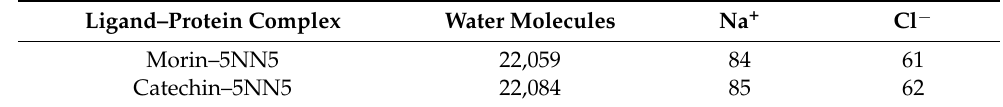
Table 2. System preparation parameters for Molecular Dynamic